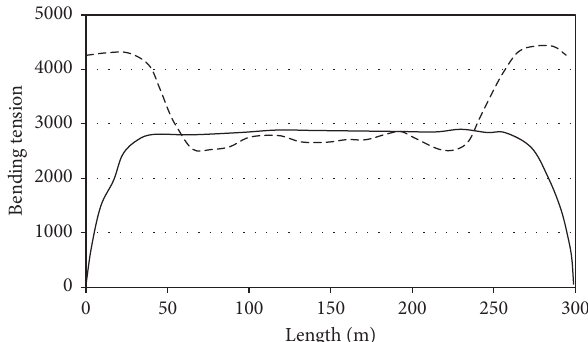
Figure 8: Variation in the extent of maximum axial tensions along the pipeline with different final conditions.